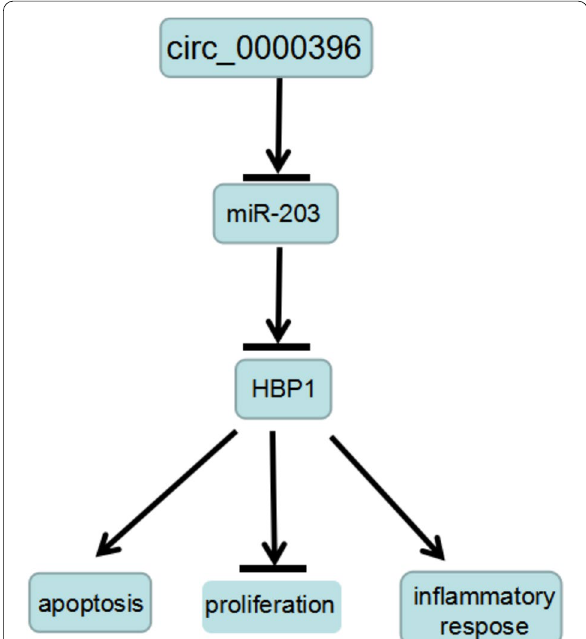
Fig. 8 Schematic model showing the role of circ_0000396 in the growth and inflammation of RASFs. Circ_0000396 could suppress RASF growth and inflammation by up-regulating HBP1 through absorbing